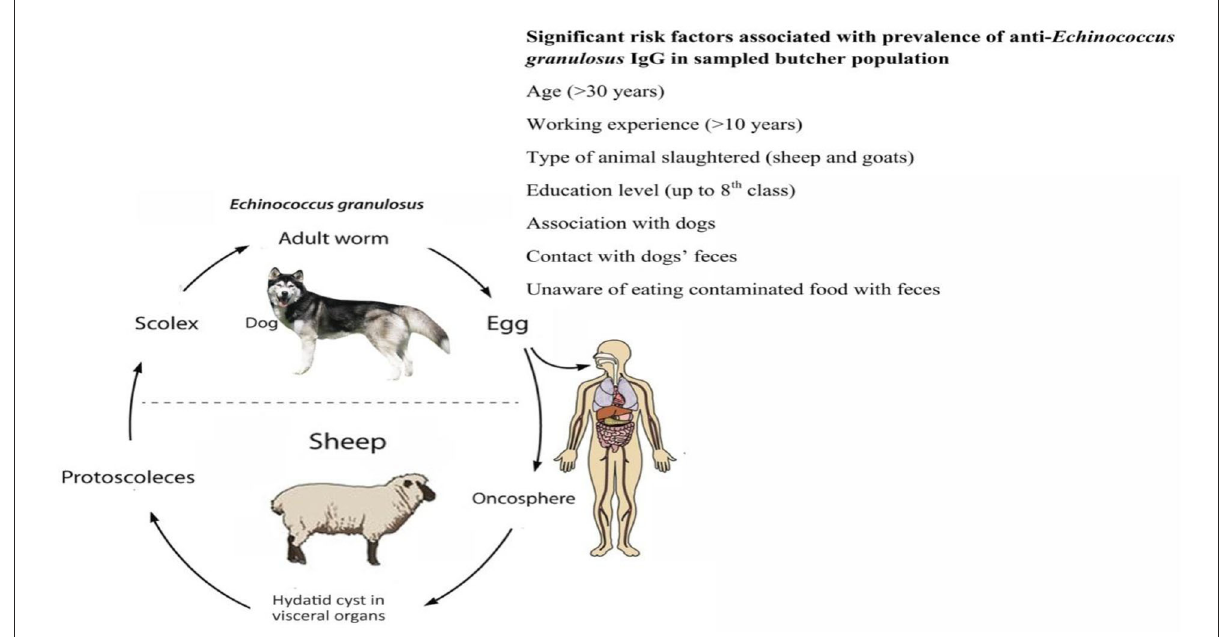
FIGURE4 Risk factors for Echinococcus granulosus in butchers.